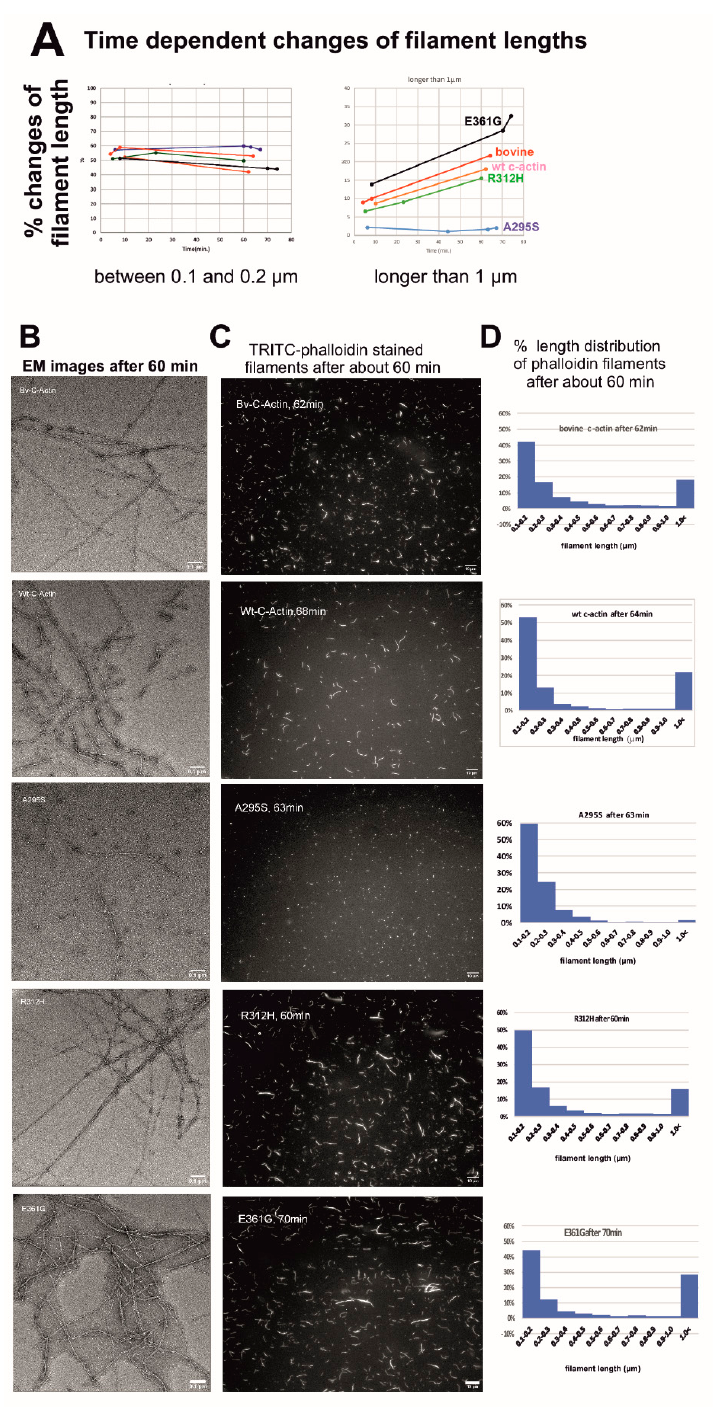
Figure 4. Filament length determination after staining with TRITC-phalloidin. ( A ) Filaments of the cardiac actin variants were labelled with TRITC-phalloidin (see Materials and Methods) and the alterations of their length distribution were followed over time for filaments of a length between 0.1 and 0.2 μ m and over 1 μ m. Note that the number of filaments between 0.1 and 0.2 μ m remained almost constant, whereas the number of filaments over 1 μ m increased, except for the p.A295S mutant. The largest increase was noted for the p.E361G mutant. ( B ) The appearance of the phalloidin labelled filaments was visualized by EM after about 60 min and ( C ) by fluorescence microscopy. ( D ) Shows the percental length distributions after about 60 min as determined by ImageJ Ridge Detection (see Materials and Methods). Bars in ( B , C ) correspond to 100 nm and 10 µ m,